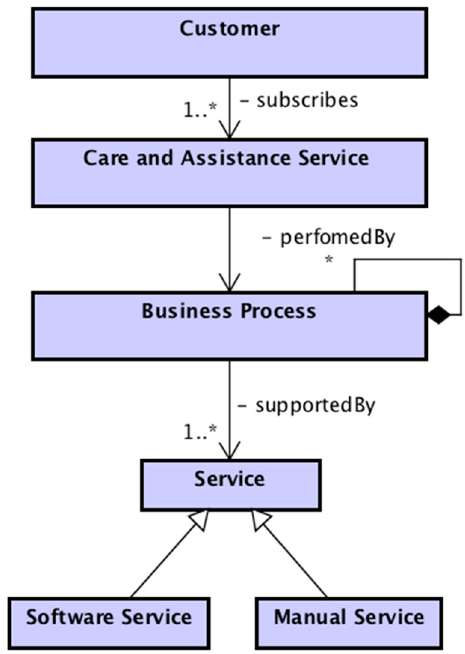
Figure 1. Care and Assistance Service in the Elderly Care Domain.